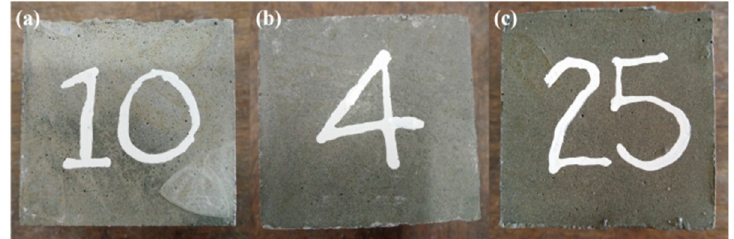
Figure 2. Physical appearances of unexposed fly ash geopolymers with ( a ) 0%, ( b ) 2% and ( c ) 4% of silica fume.